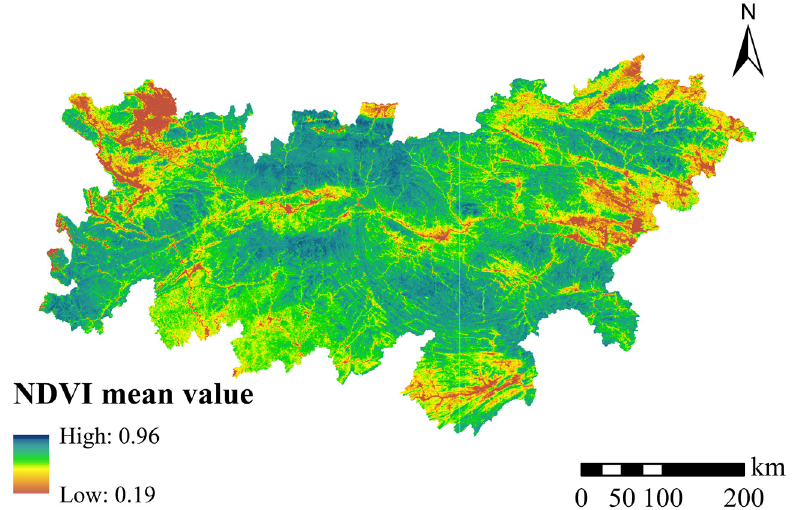
Figure 4. Spatial pattern of multi-year annual mean NDVI in the QBM (2003–2018).